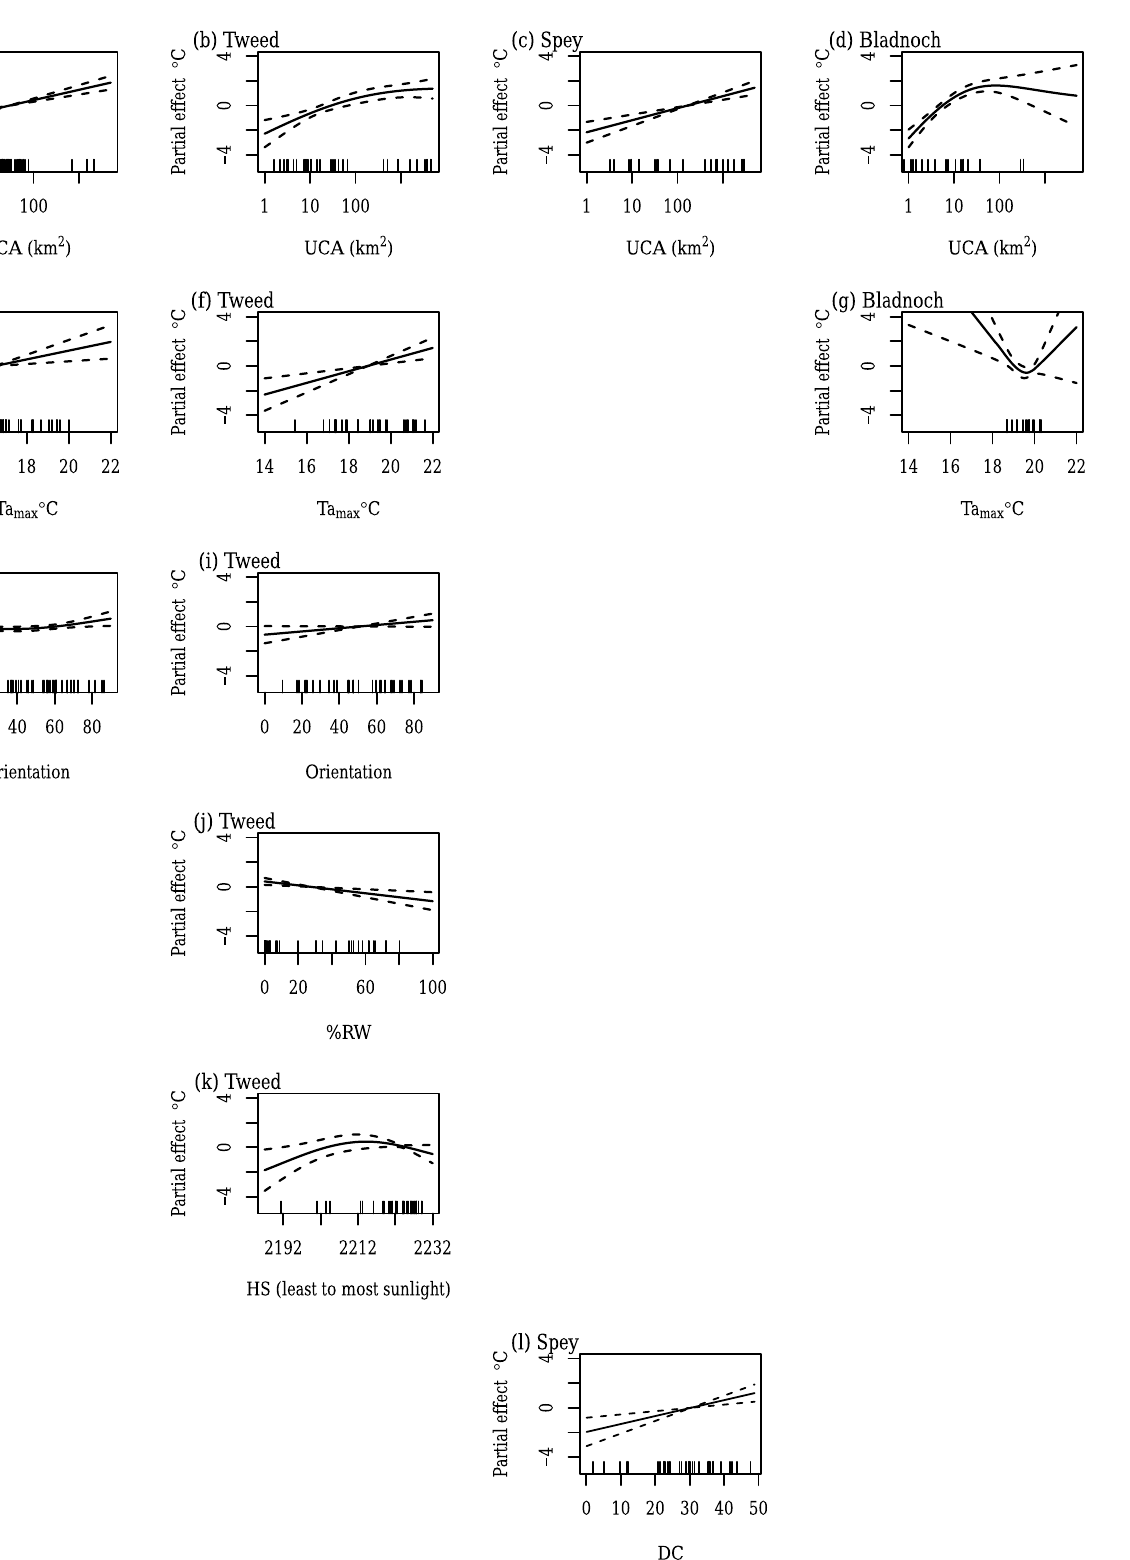
Figure 4. LS_ T a model effects with pointwise 95% confidence bands. Each column corresponds to a catchment and each row to a covariate. (a) Dee UCA, (b) Tweed UCA, (c) Spey UCA, (d) Bladnoch UCA, (e) Dee T a (i) Tweed Orientation, (j) Tweed %RW, (k) Tweed HS and (l) Spey